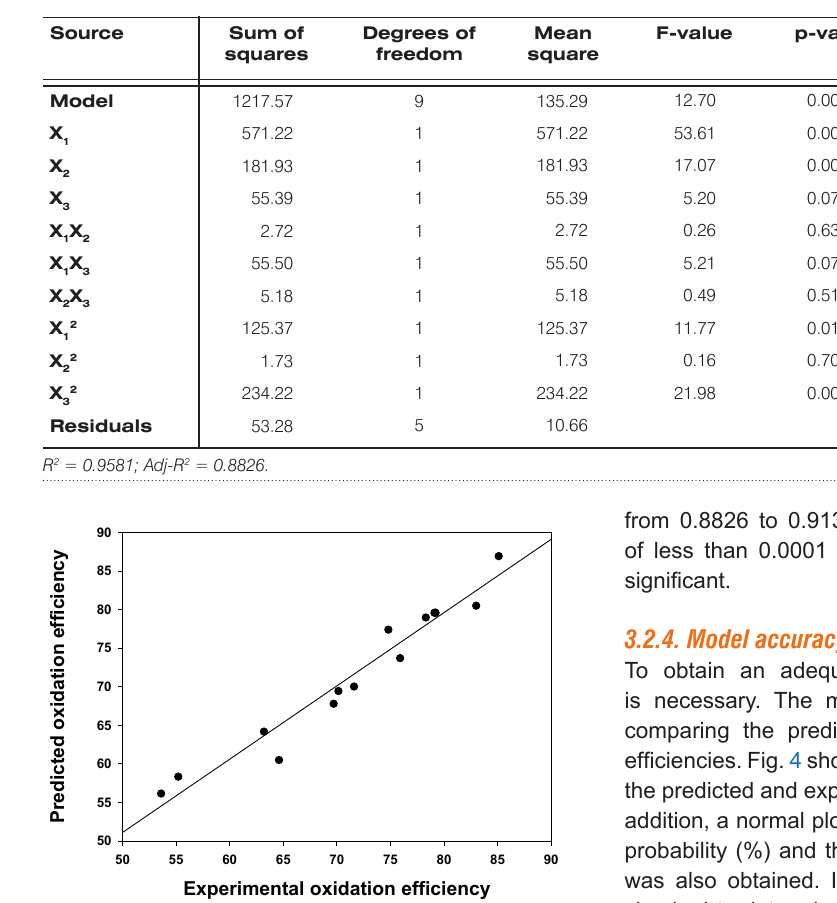
Table 4. Analysis of variance results for acquired